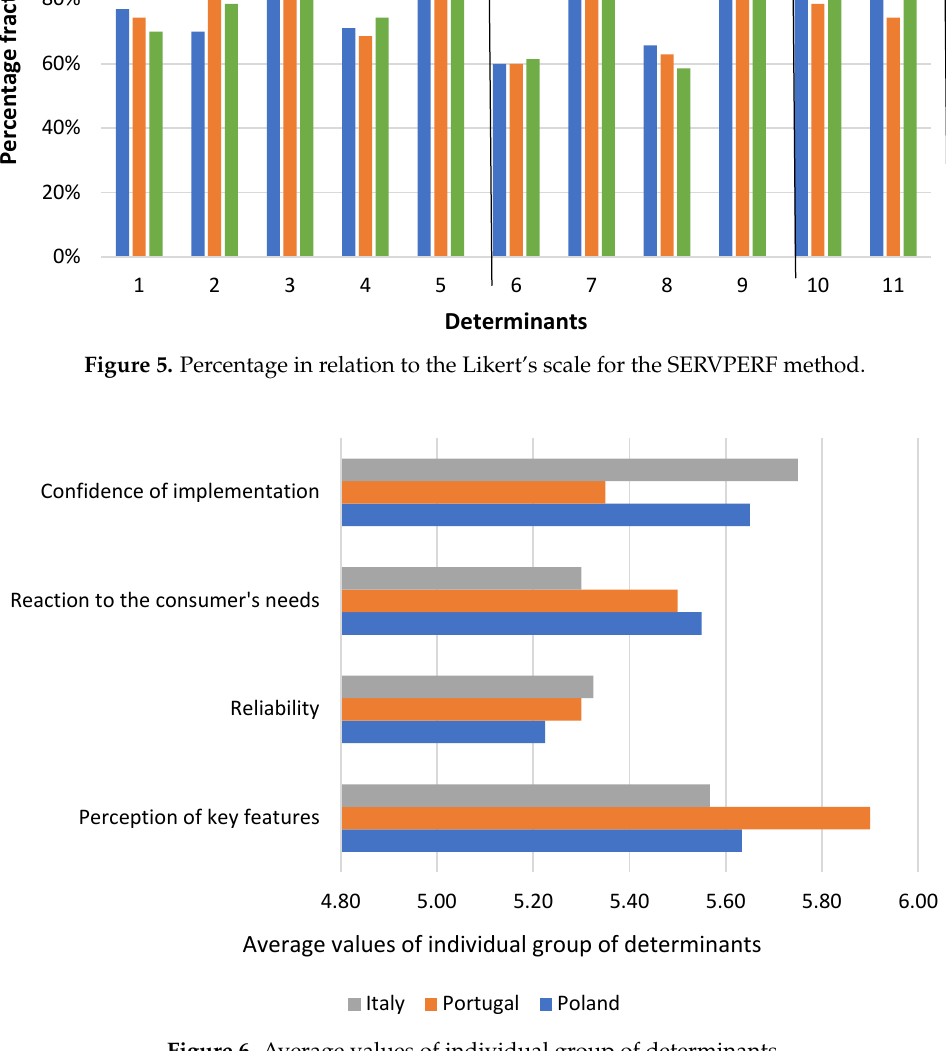
Figure 6. Average values of individual group of determinants.